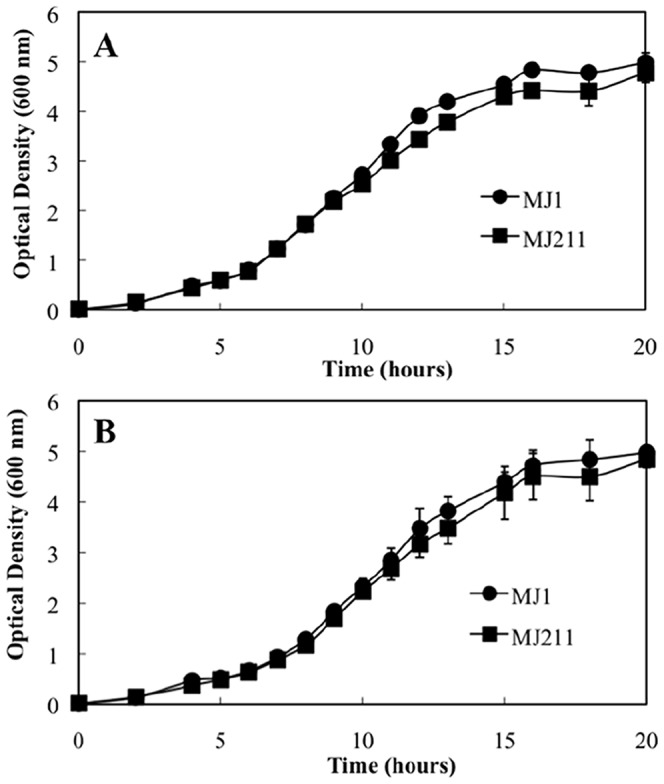
Impact of luxI deletion on growth of Vibrio fischeri in isolation.Batch culture growth of V. fischeri wild type strain MJ1 (circles) and luxI deficient mutant strain MJ211 (squares) in the absence (A) and presence (B) of 5 µM N-3-oxohexanoyl-L-homoserine lactone. Values presented are averages of triplicate cultures. Error bars represent standard deviation. Small statistically significant differences were late in the logarithmic phase of growth.